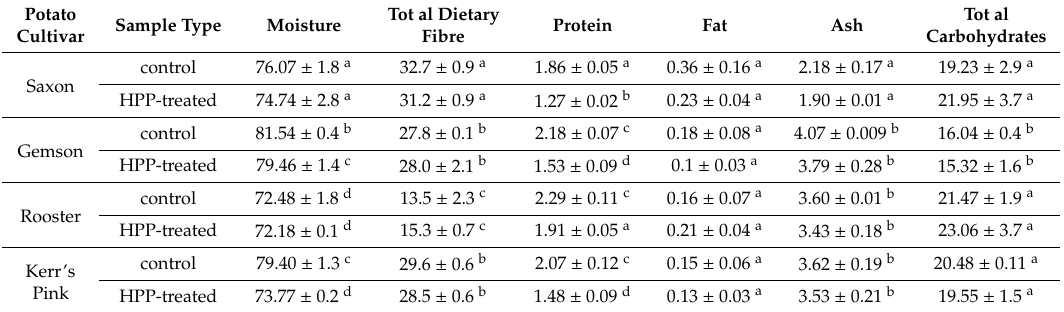
Table 1. Proximate composition in percentages (%) of untreated (control) and treated with high pressure processing (HPP) potato